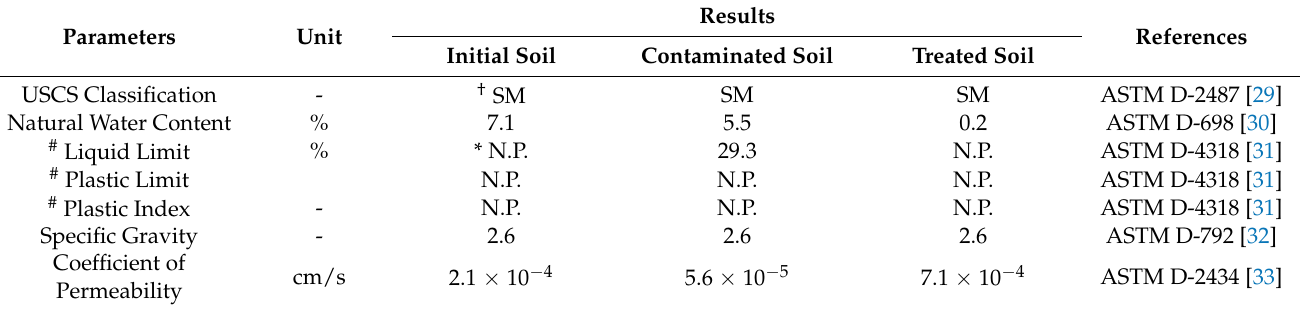
Table 2. Chemical composition of lubricant oil.